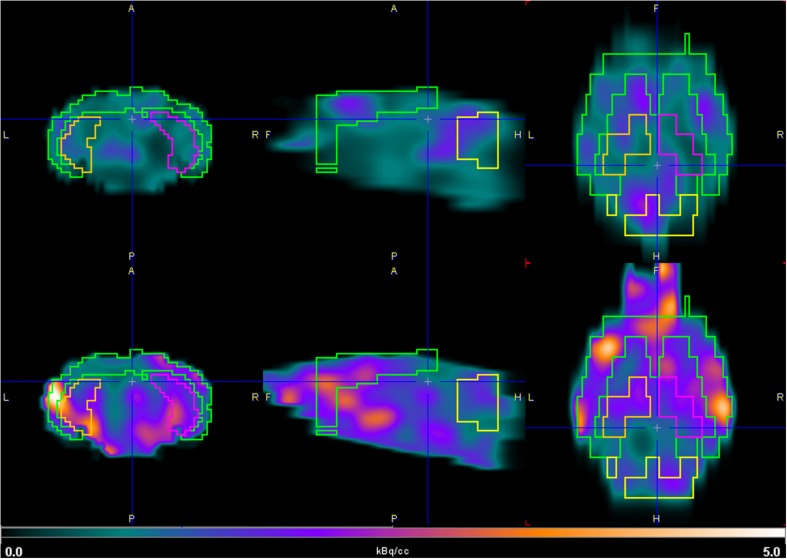
Coronal (left), sagittal (middle), and axial (right) PET images of [18F]2B-SRF101. Brain uptake of 3xTg mouse model (down) and control group (up) in the hippocampus and cortex between 35 and 65 min, depicted using a common scale from 0.0 to 5.0 kBq/cc.